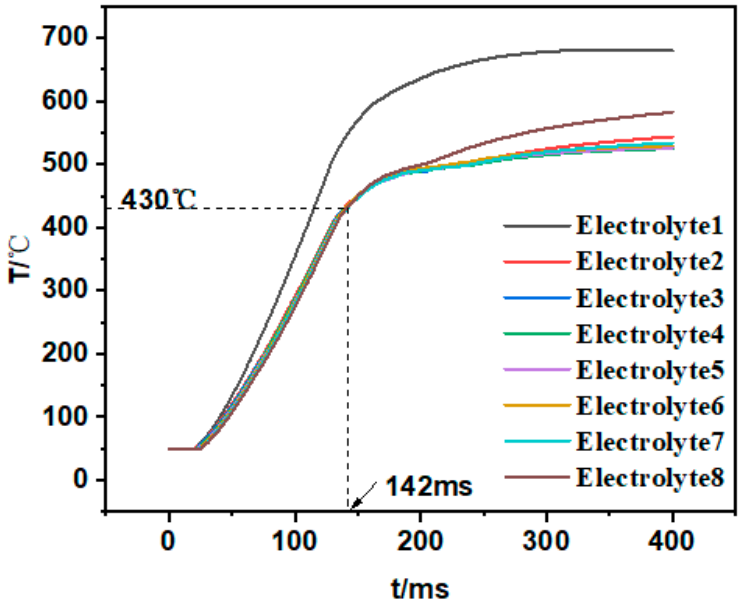
Figure 6. Average temperature rising curves of the electrolytes.